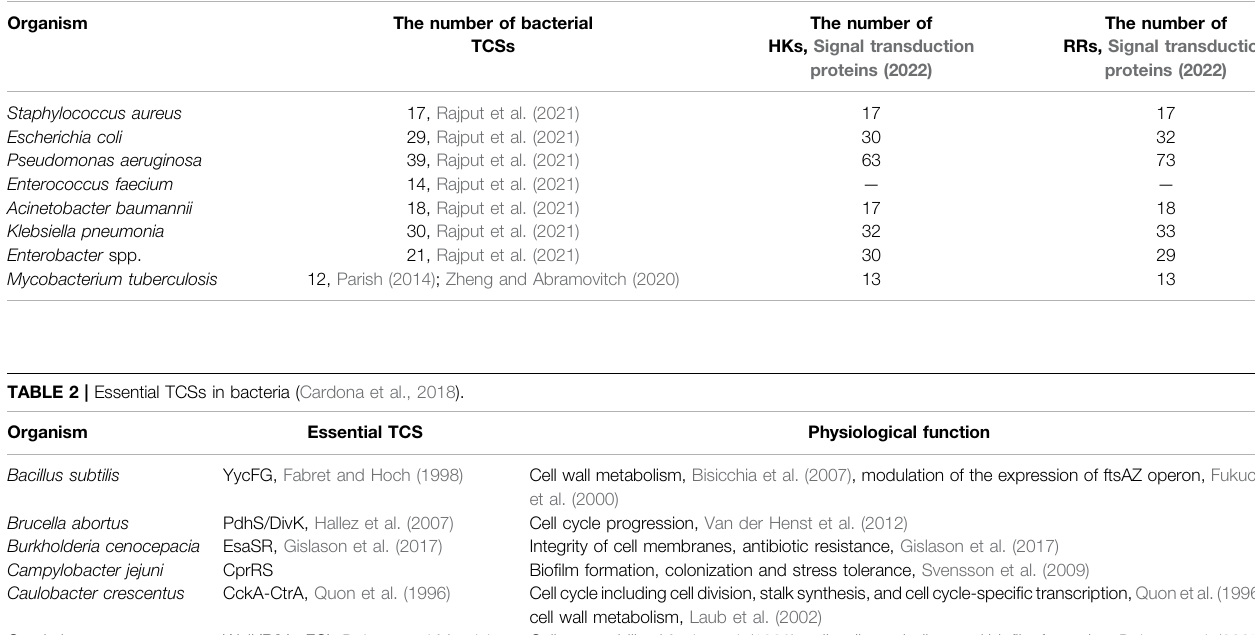
The number of TCSs HKs, Signal transduction